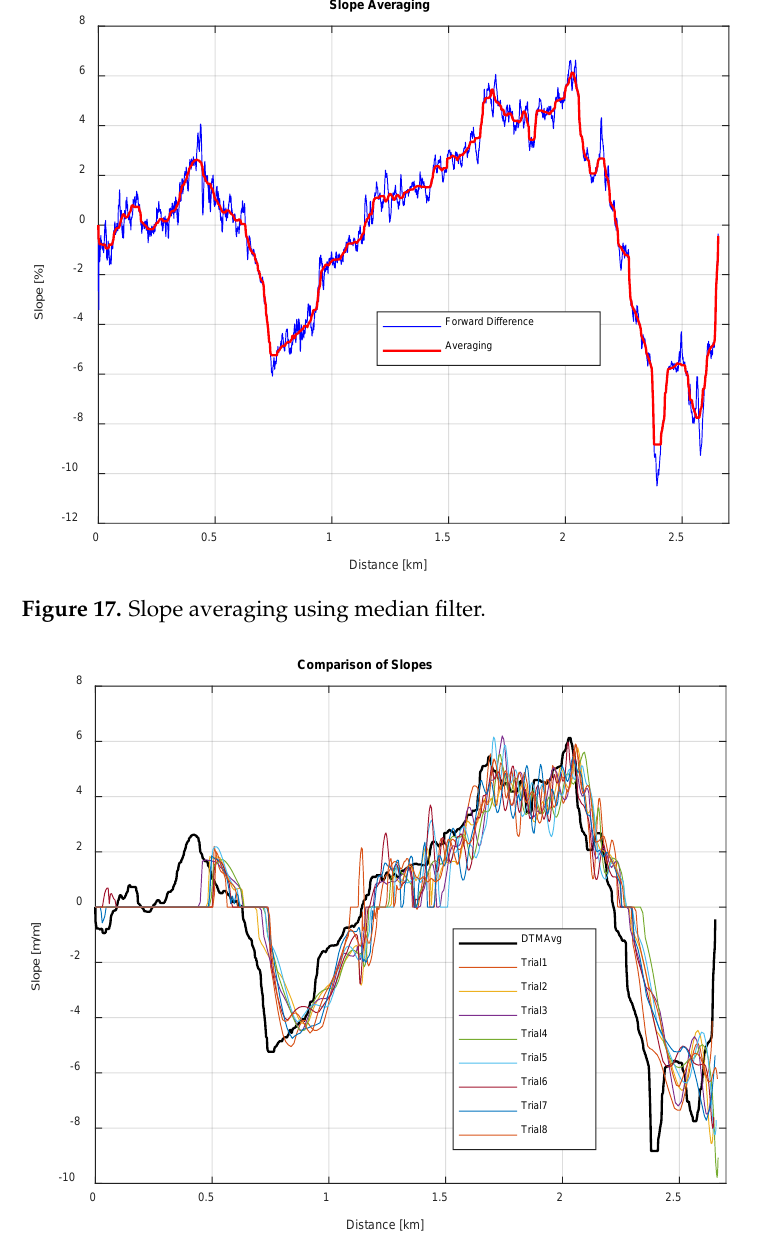
Figure 18. Slopes recorded by the computer.